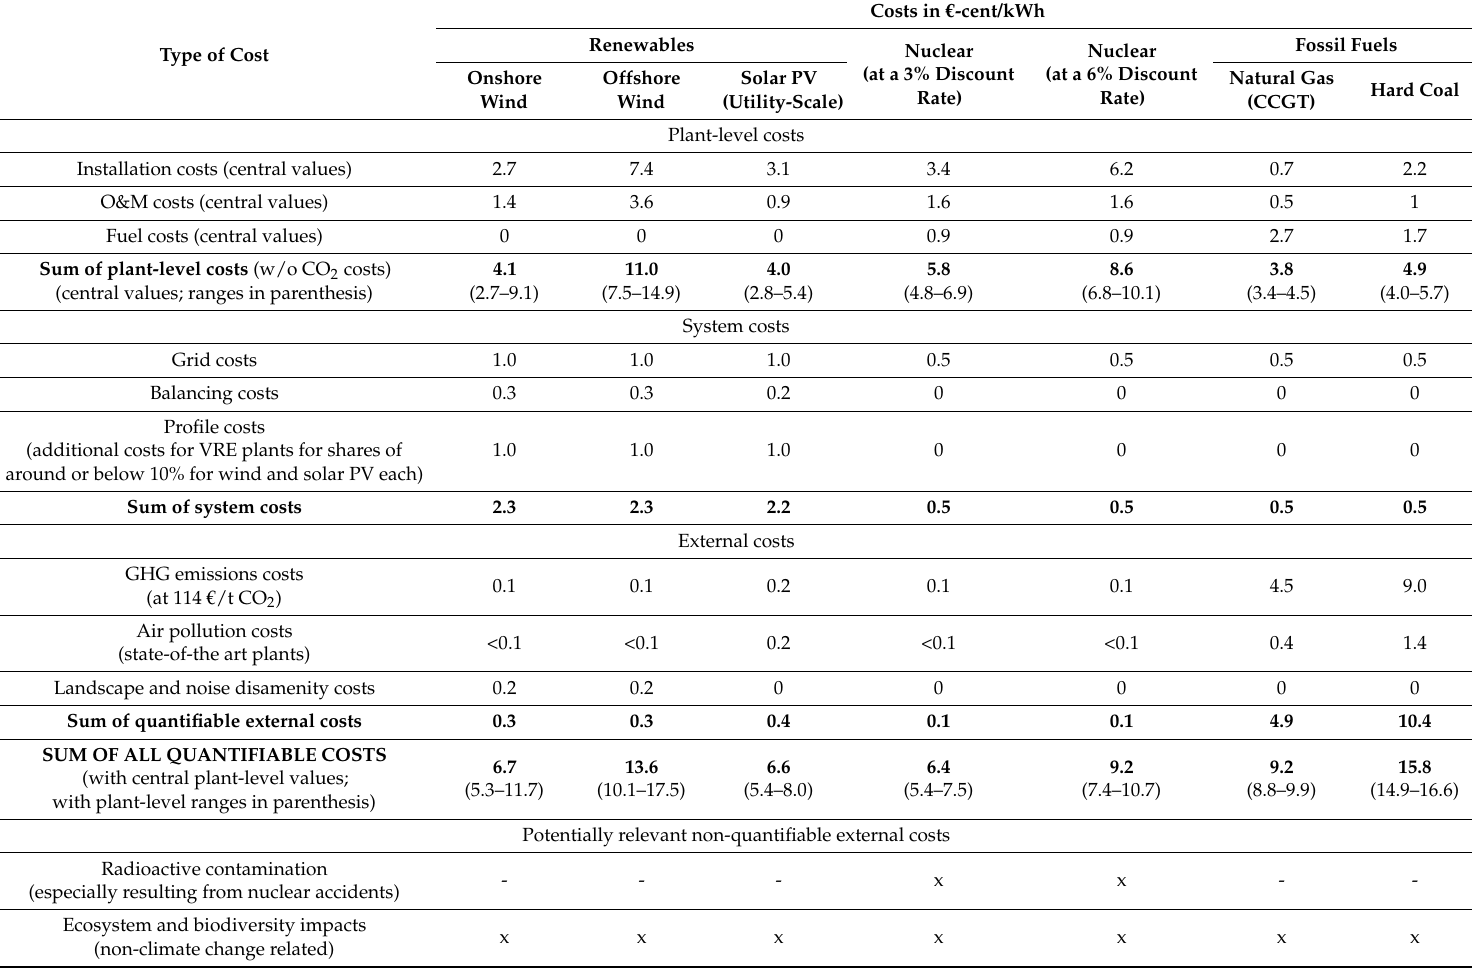
Table 11. Overview of the estimated specific social costs of electricity generation in the USA from several types of current newly-built power plants.